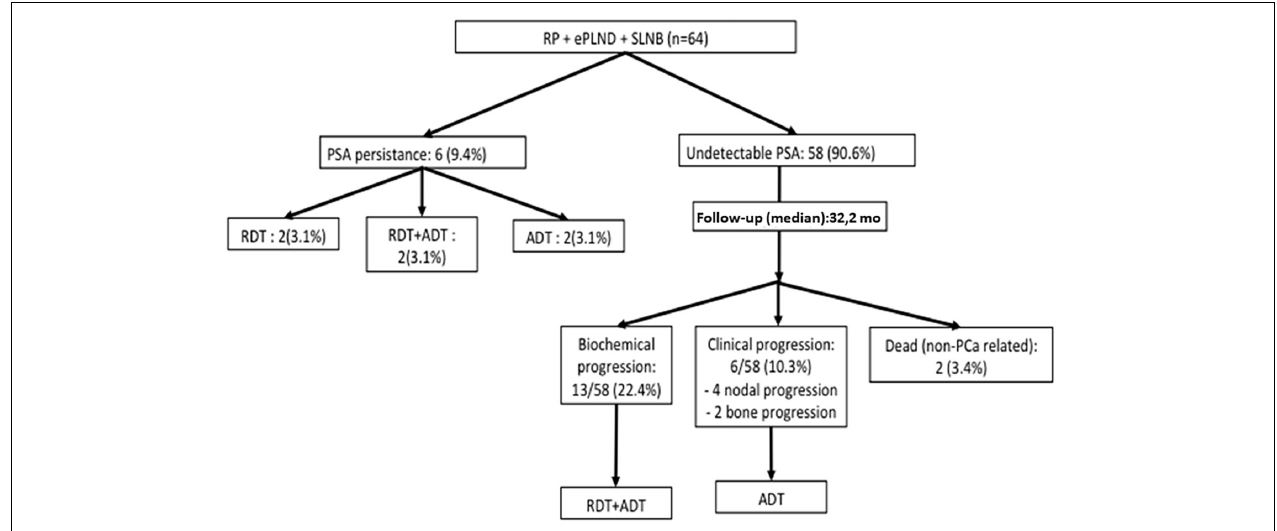
FIGURE 4 | Follow-up flow-chart diagram. RP, radical prostatectomy; ePLND, extended pelvic lymphadenectomy; SLNB, sentinel lymph node biopsy; RDT, radiotherapy; ADT, androgen deprivation